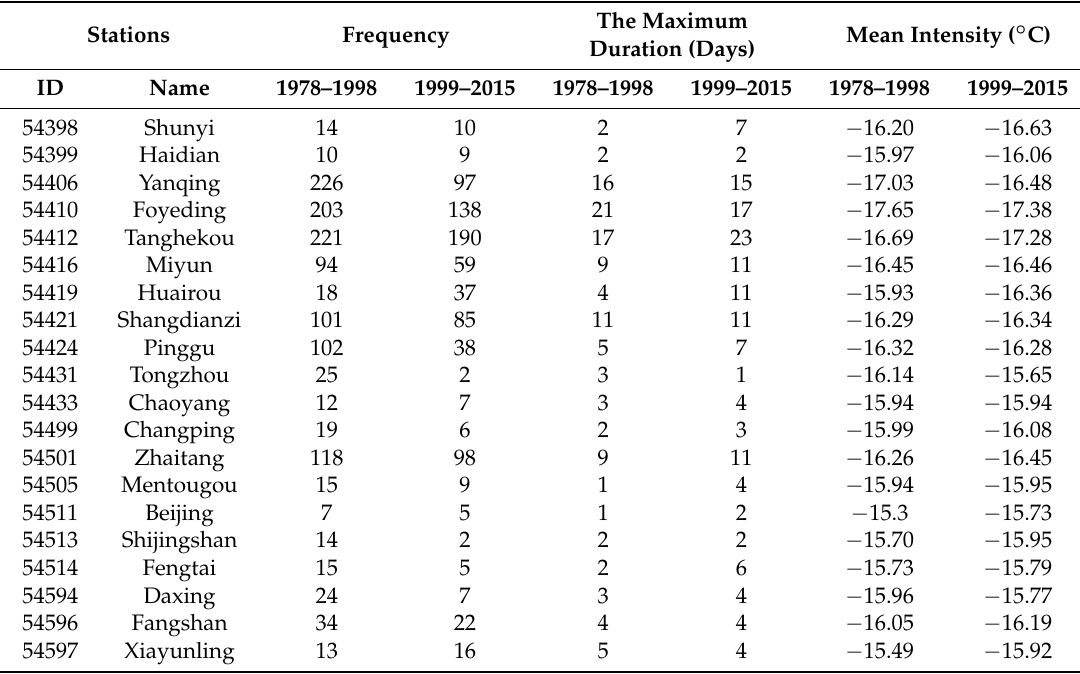
Table 6. Statistics of extreme low temperature events for 20 meteorological stations in